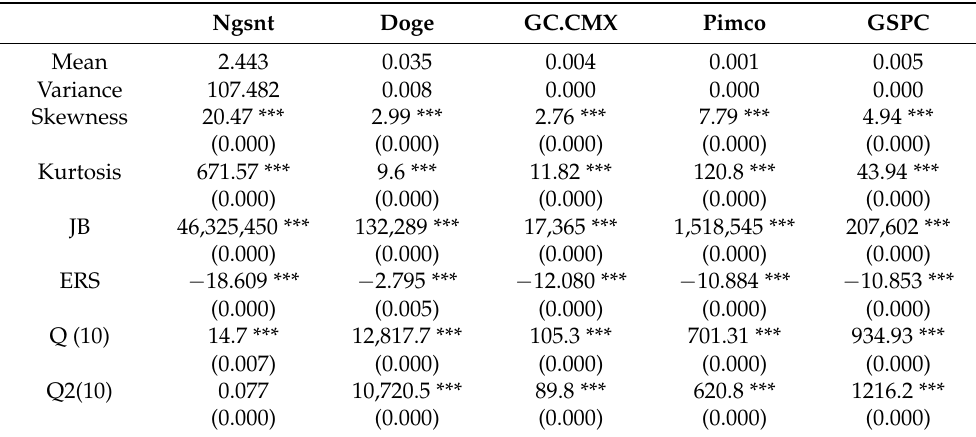
Table 2. Descriptive statistics of all five